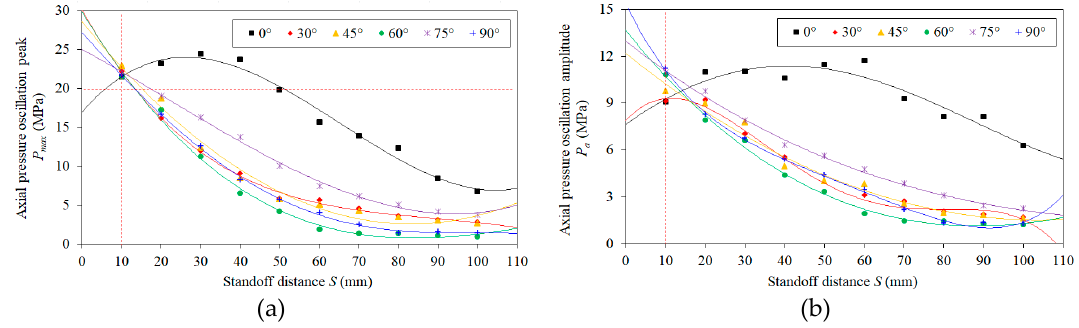
Figure 6. P max ( a ) and P a ( b ) as a function of S at P i = 20 MPa.